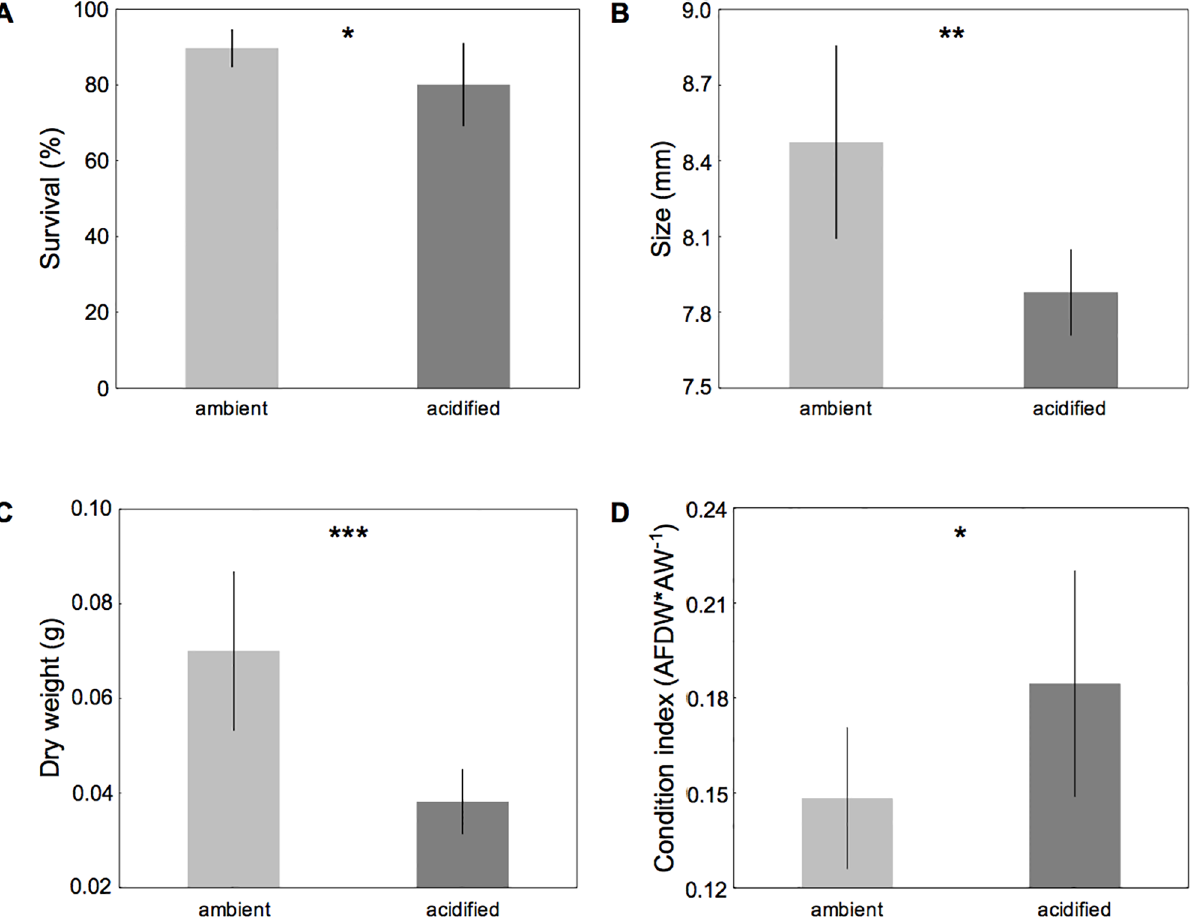
Fig 3. Survival (A), size (B), dry weight (C) and condition index (D) of field-collected barnacle assemblages. B . improvisus was incubated at two different pH treatments ( Δ of 0.6 pH units) for 8 months. Deviations denote 95% CIs from the mean. Main ANOVA effects are indicated by (cid:3) p < 0.05, (cid:3)(cid:3) p < 0.01, (cid:3)(cid:3)(cid:3) p < 0.001 (N =